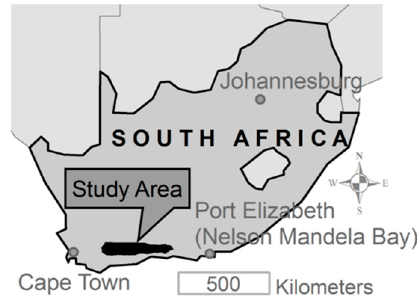
Figure 1. The Little Karoo Study Region.